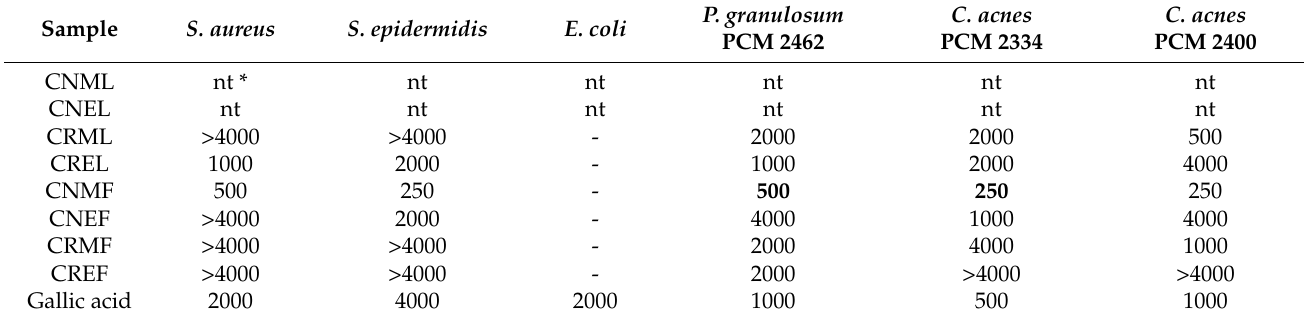
Table 6. Minimal inhibitory concentration (MIC [ µ g/mL]) values of the extracts obtained from the fruits or leaves of C. roseus or C. nebrodensis . Bold indicates the better antibacterial activity of C. roseus or C. nebrodensis extracts compared to Gallic